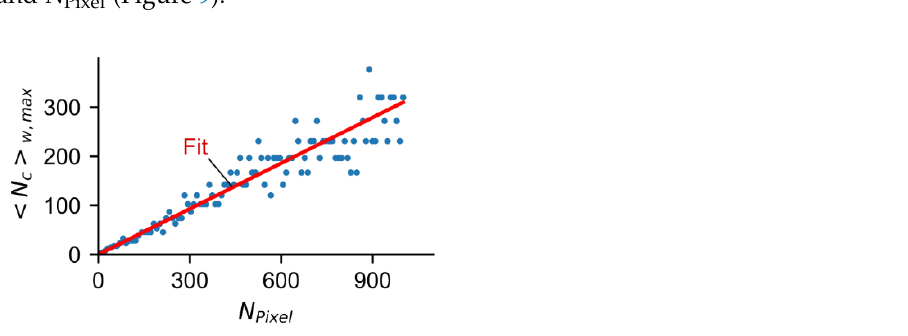
Figure 9. 〈𝑁 c 〉 w,max vs. 𝑁 Pixel determined from Monte Carlo simulations show a linear correlation. Figure 9. (cid:104) N c (cid:105) w,max vs. N Pixel determined from Monte Carlo simulations show a linear